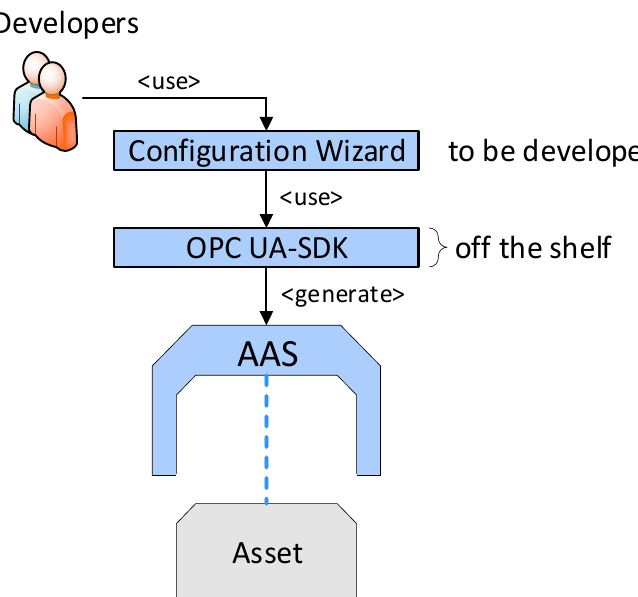
Figure 3. A block diagram to define the functioning of ConfigWizard.